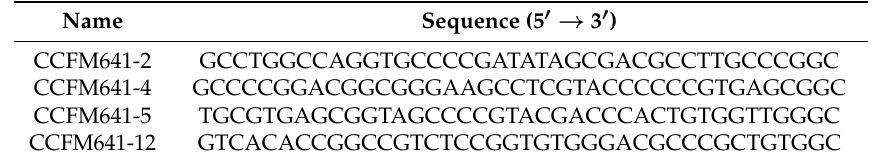
Table 1. Tested aptamer sequences a .